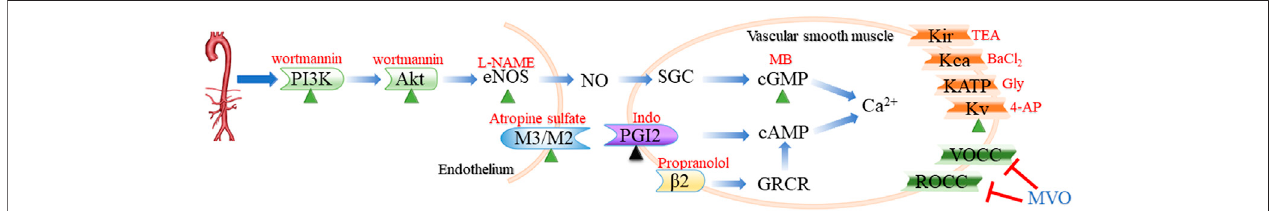
FIGURE 10 | Routes of vasodilation mechanisms that participated in the vasorelaxation of MVO. The green triangle indicated that the activation of the mechanism was conducive to MVO ’ s vasorelaxant effect, while the black triangle suggested whether the activation of the mechanism was bene fi cial to MVO ’ s vasorelaxant effect depending on the type of pre-constrictor. The red T indicated that MVO exerted a vasorelaxant effect by inhibiting this mechanism. Blue words denoted MVO, and red words denoted common blockers of the corresponding pathways. eNOs, endothelial nitricoxide synthase; SGC, soluble guanylyl cyclase; cGMP, cyclic 3 ′ ,5 ′ - guanosinemonophosphate;PGI2,prostaglandin2;cAMP,cyclicadenosine3 ′ ,5 ′ -monophosphate;L-NAME,nitro-L-arginine;MB,methyleneblue;Indo,indomethacin; Gly, glibenclamide; 4-AP, 4-aminopyridine; TEA,